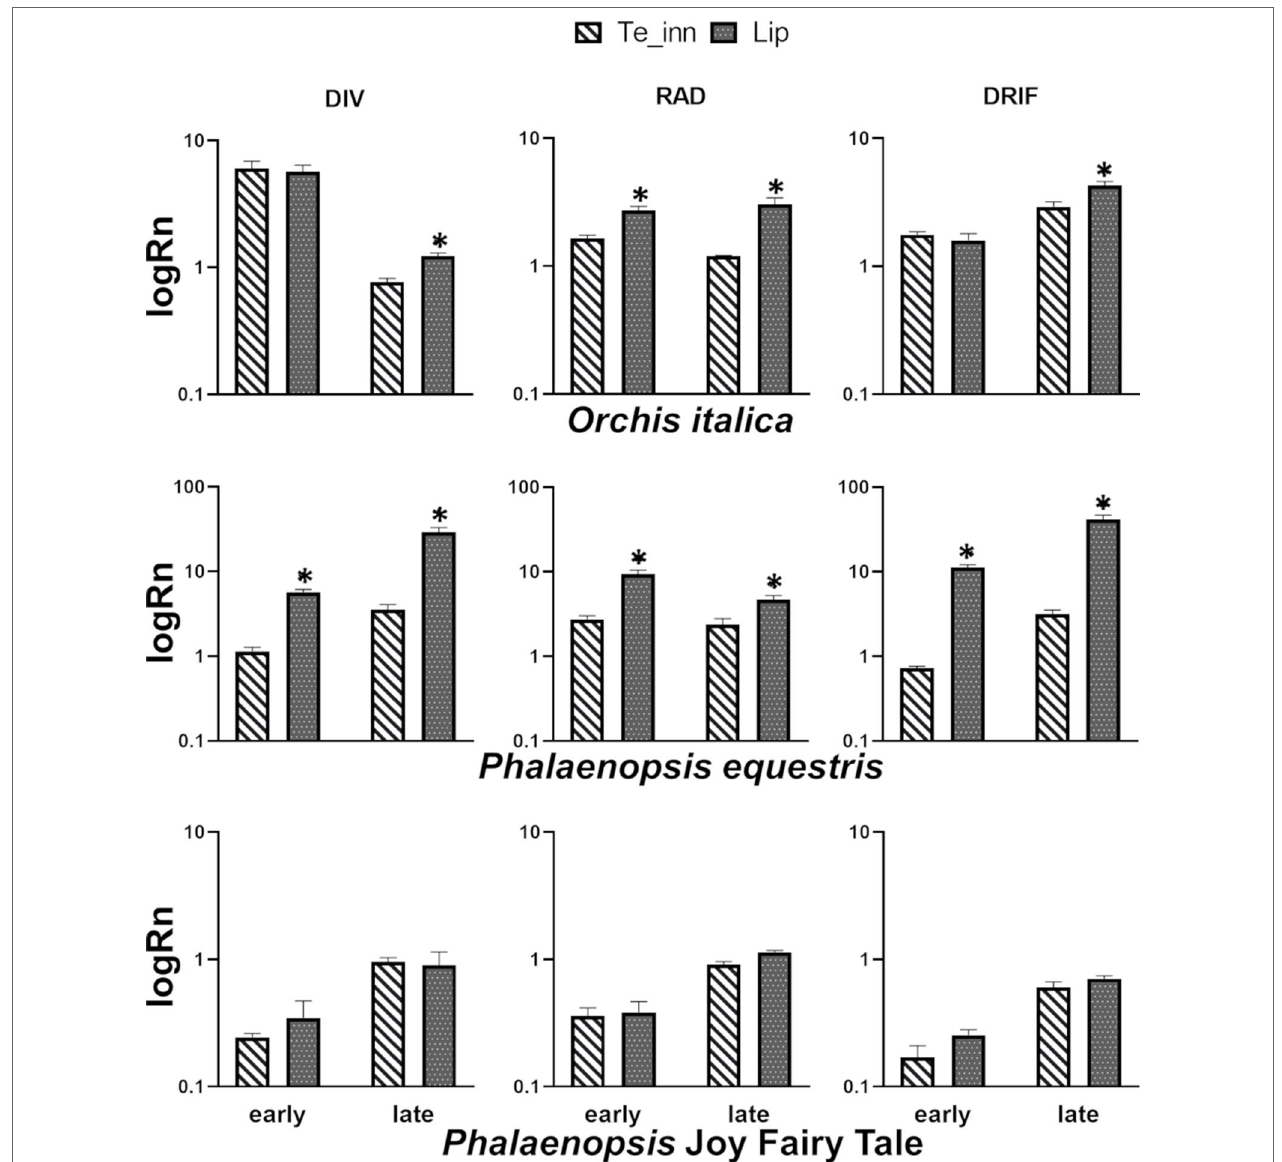
FIgURE 6 | Relative expression of the orchid DIV , RAD , and DRIF1 genes in lateral inner tepals ( Te_inn ) and lip of Orchis italica , Phalaenopsis equestris , and Phalaenopsis Joy Fairy Tale. The relative expression Rn (expressed as log 10 of the mean between technical duplicates of three biological replicates) is normalized with respect to 18S endogenous gene and outer tepal tissue. The bars represent SEM and the asterisks indicate significant difference in relative expression between lateral inner tepals and lip assessed by t test. Early and late indicate before and after anthesis stage, respectively.